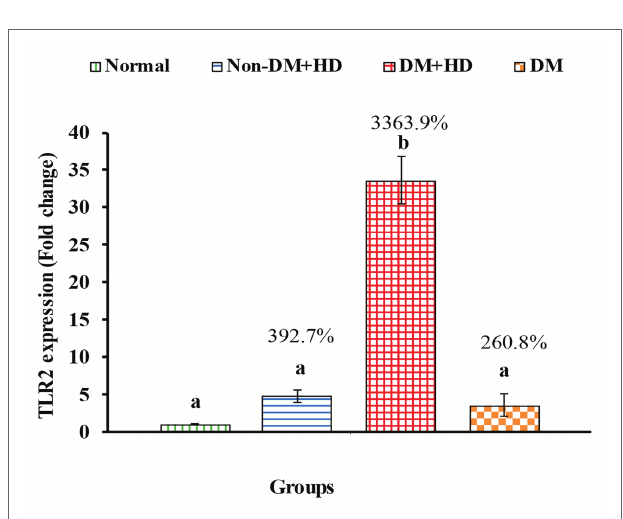
FIGURE 4 | The expression of Toll-like receptor 2 (TLR2) in the blood of non-diabetic and diabetic patients with or without kidney failure. Means, which have different superscript letters, are significantly different at p < 0.05. Percentage changes were calculated in comparison with normal group. Value of p : 0.001.